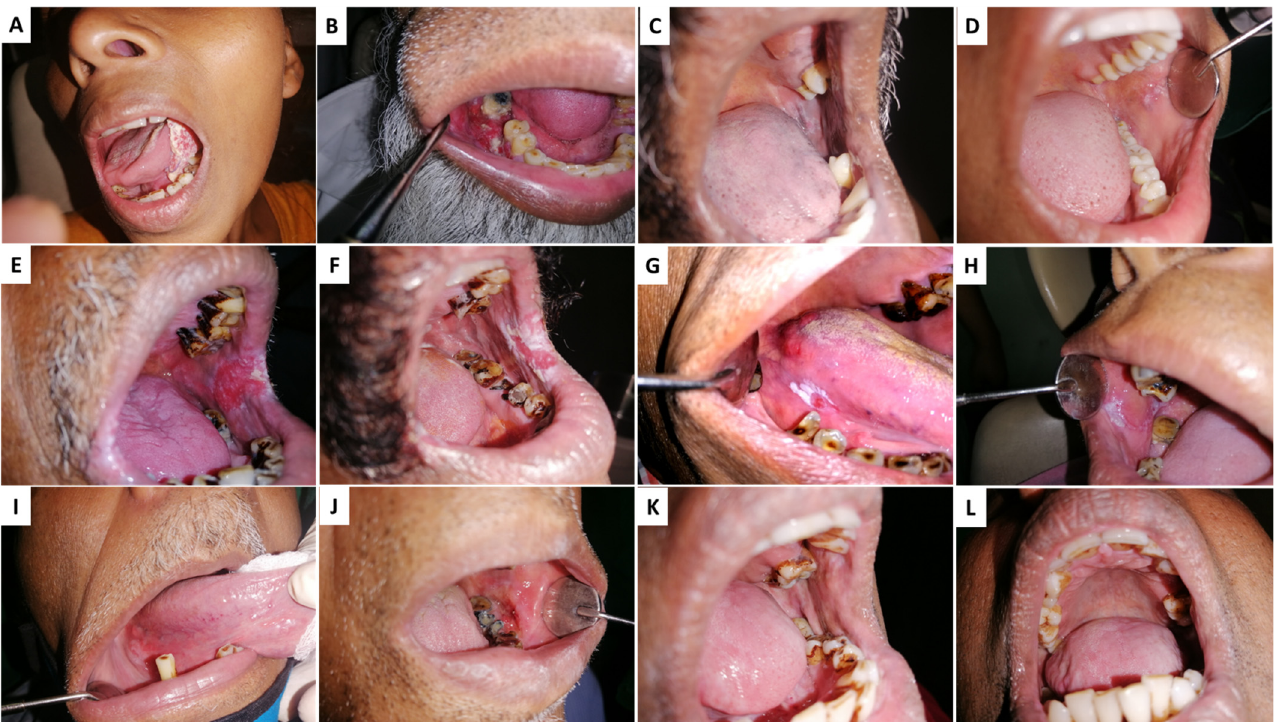
Figure 1. Clinical conditions associated with Areca nut (AN) chewing: ( A , B ) Oral squamous cell carcinoma—OSCC, ( C , D ) Oral lichenoid reactions—OLL, ( E , F ) oral erythroplakia—OE, ( G , H ) oral leukoplakia—OL ( I , J ) Erythroleukoplakia, ( K , L ) Oral lichen planus—OLP.